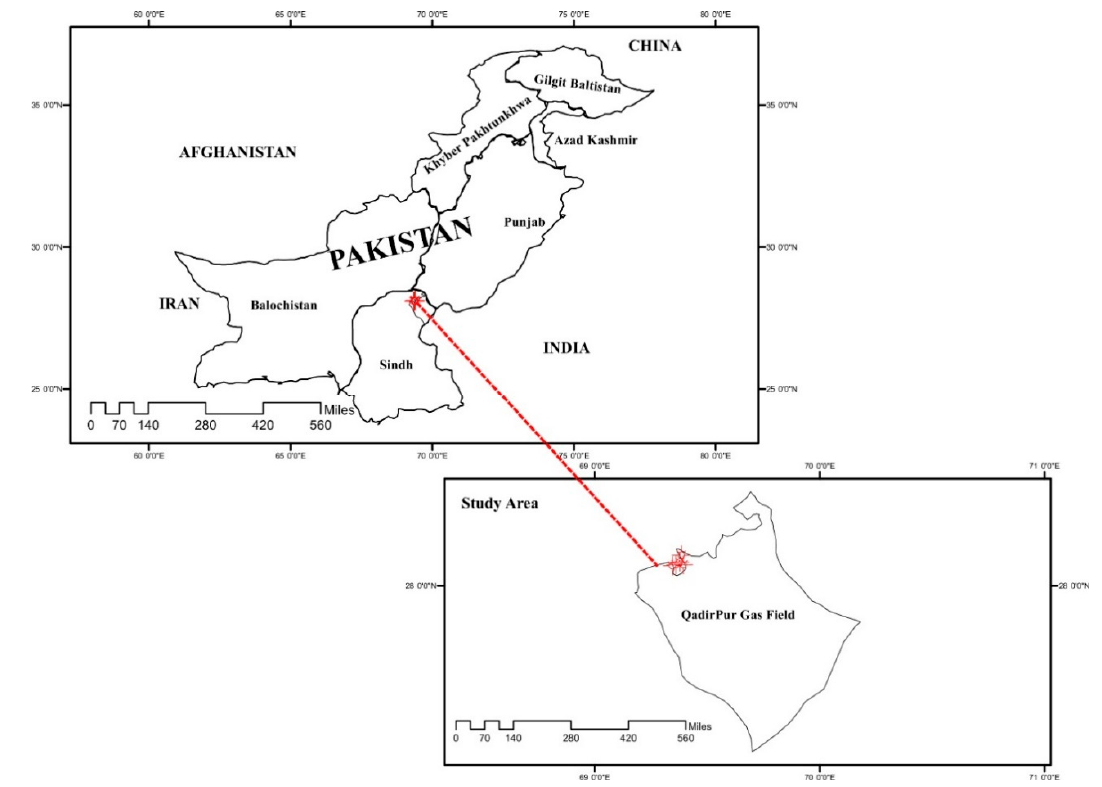
Figure 1. Location map of the Qadirpur gas field (QGF).